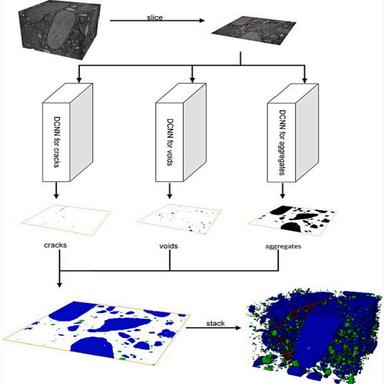
Flowchart of reconstructing concrete's 3D microstructural phase segmentation with DCNN models. Image reproduced from.